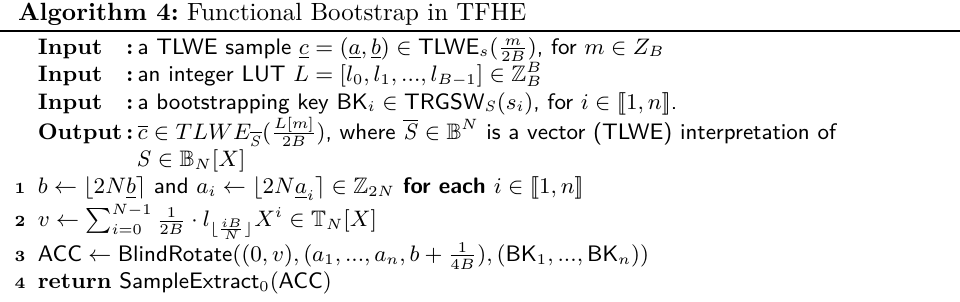
Algorithm 4: Functional Bootstrap in